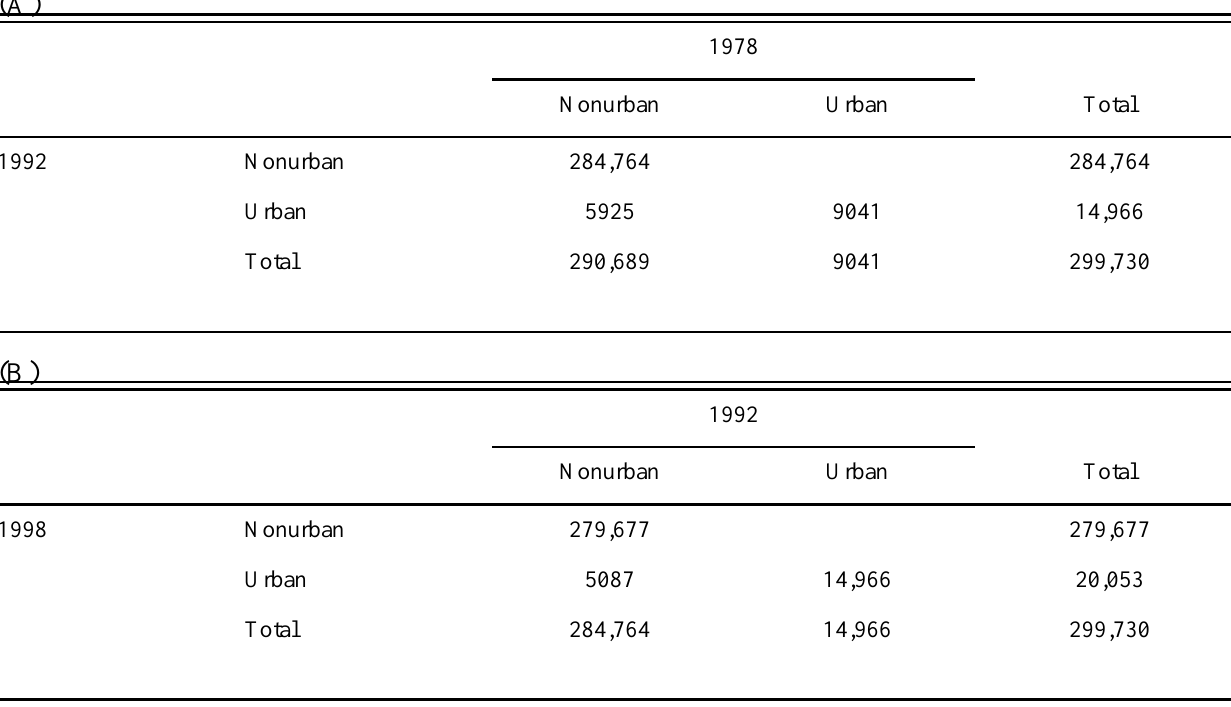
Table 2. Transition matrices of urban land use for (A) 1978 to 1992 and (B) 1992 to 1998. Values indicate the number of urban and nonurban cells; the matrix diagonal indicates cells that did not undergo change during the study